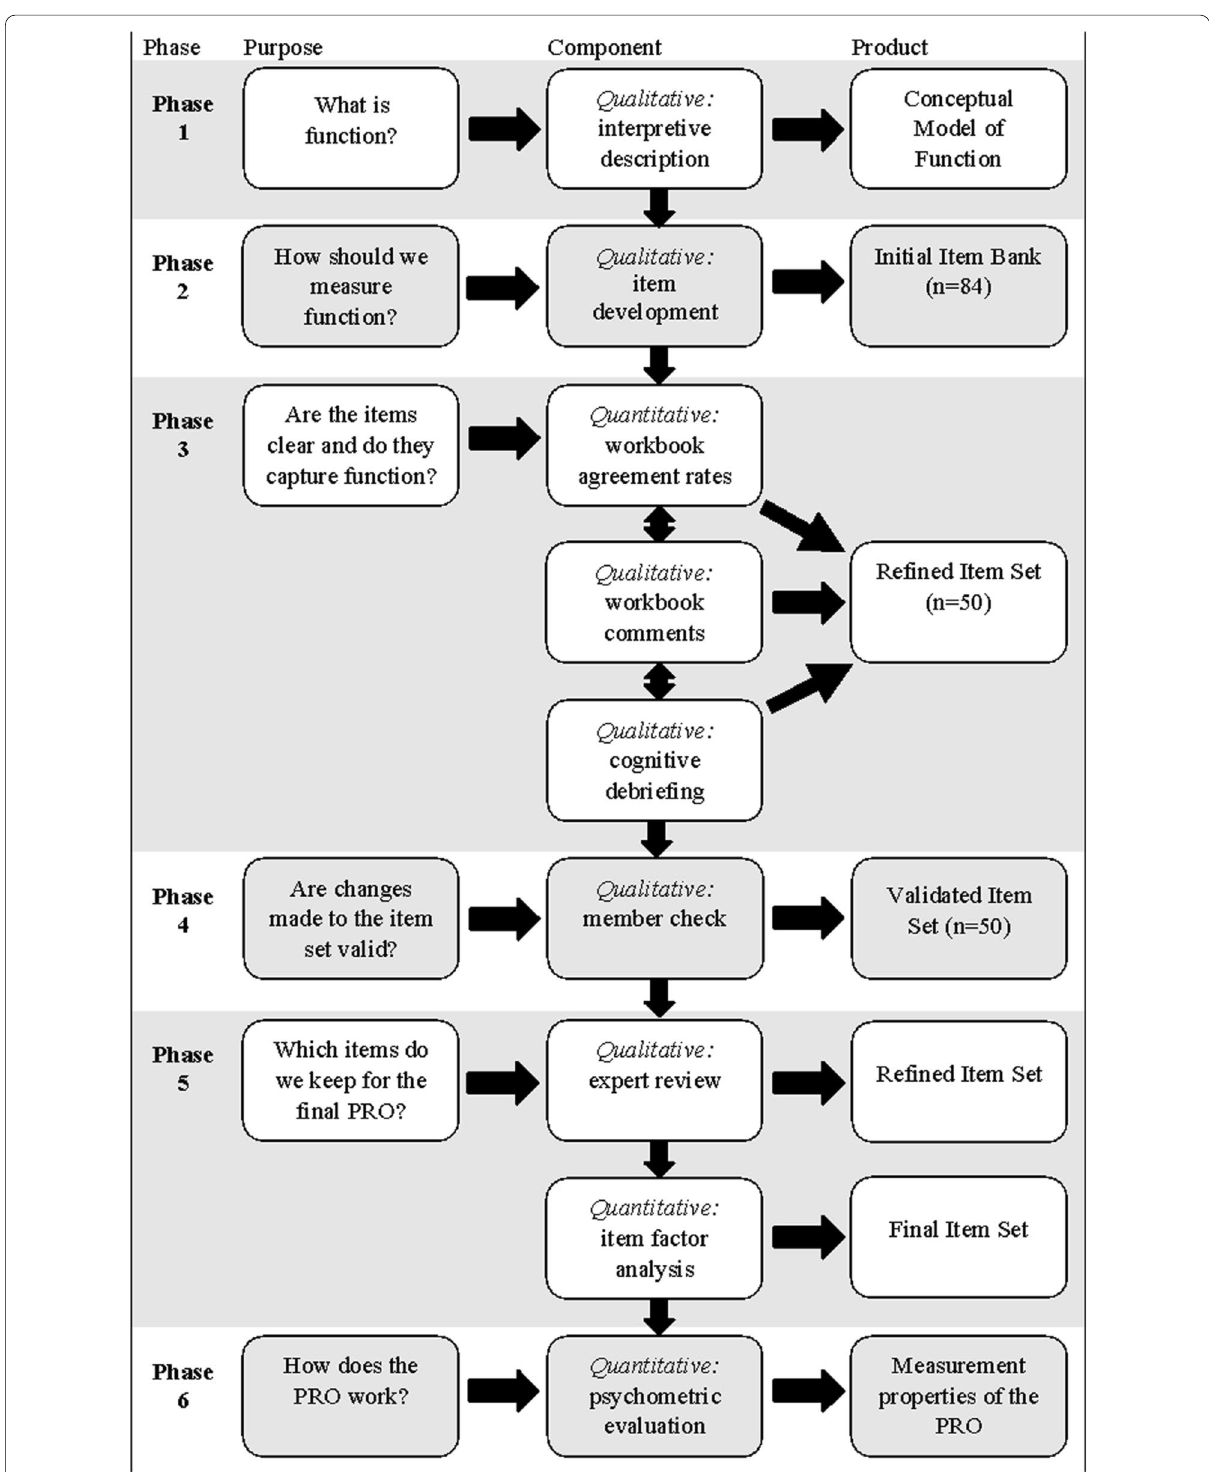
Fig. 1 Mixed-methods patient-reported outcome (PRO) development